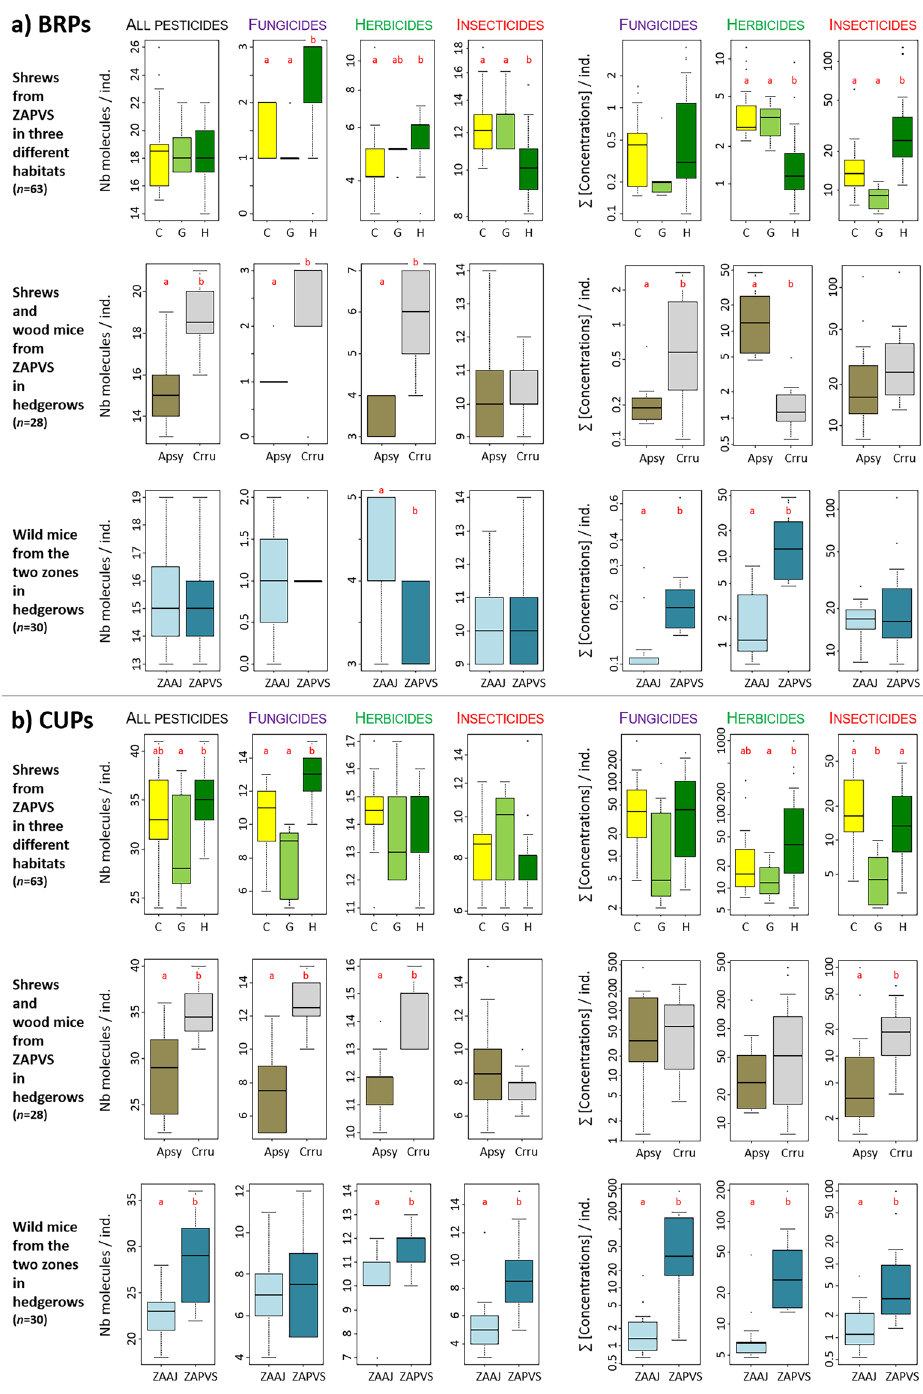
Figure 1. Boxplots of number of molecules and sum of concentrations for ( a ) banned and restricted pesticides (BRPs) and ( b ) currently used pesticides (CUPs) according to habitats, species and sites. Statistical differences between groups are indicated by lower case letters, different letters indicate statistically significant differences between factor levels (statistical significance: p-value< 0.05). C cereals, G grasslands, H hedgerows,